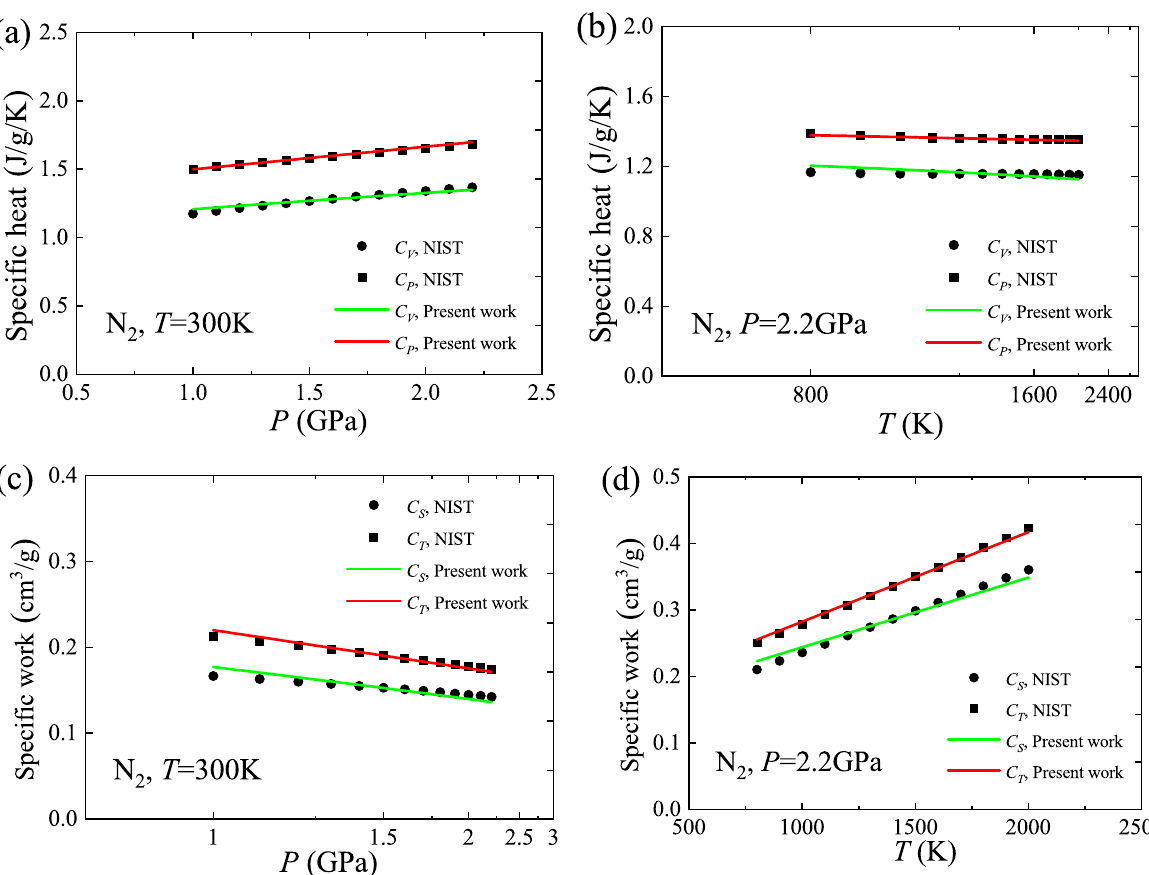
Figure 1. Verification of the specific heats and specific works using N 2 data. ( a ) Specific heats versus pressure at 300 K; ( b ) Specific heats versus reciprocal temperature at 2.2 GPa; ( c ) Specific works versus reciprocal pressure at 300 K; ( d ) Specific works versus temperature at 2.2